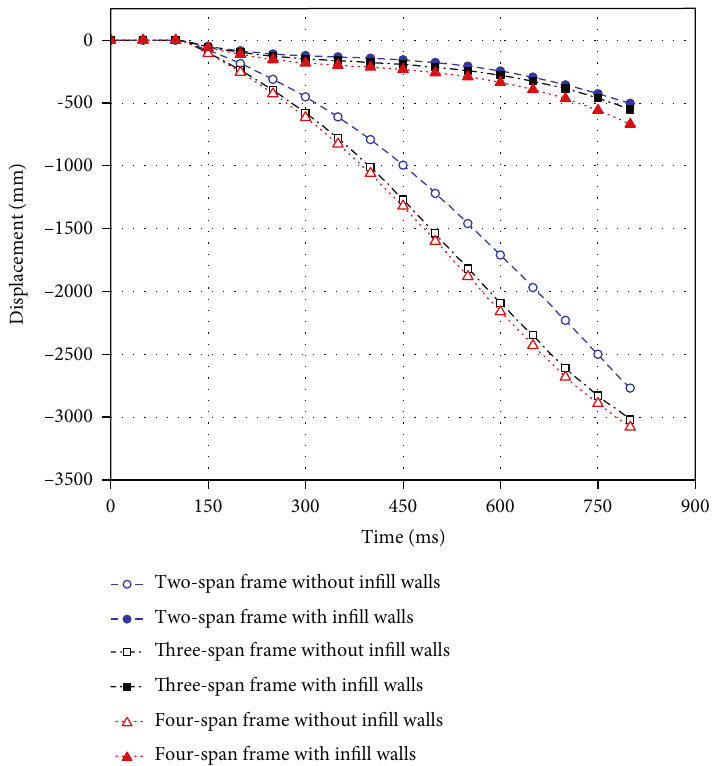
Figure 17: The z -directional displacement at the midpoint of the second-story side column after